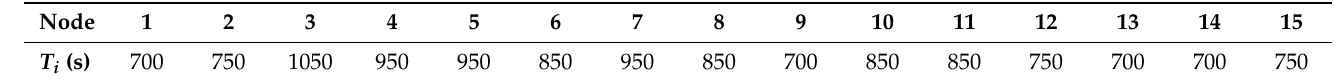
Figure 11. The monitoring period in an incomplete environment obtained by OMACO algorithm. 5. Conclusions This research has studied the problem of multi-UAV persistent monitoring path planning from the perspective of monitoring privacy protection, reducing monitoring overdue events, and improving the privacy protection of the monitoring trajectory. A multi-UAV path planning mathematical model was established based on the monitoring overdue time and monitoring period entropy. Based on the overdue time, the heuristic function, transition probability and pheromone update, the strategy of the traditional ACO is improved. The simulation results show that the proposed OMACO algorithm can solve the optimal UAV flight path efficiently in both complete and incomplete monitoring environments and has better performance than ACO. This study is promising for the pre- vention of intelligent intrusions while meeting the requirements of regular monitoring. However, as the complexity of the monitoring environment increases, there may be adversarial targets destroying monitoring tasks, and the privacy protection requirements may be more stringent. Subsequent consideration will be given to localize adversarial ob- jects cooperatively while executing persistent monitoring assignments. Author Contributions: Conceptualization, Y.C.; methodology, Y.S.; software, Y.C. and Y.S.; formal analysis, Y.C. and Y.S.; investigation, Y.C. and Y.S.; writing—original draft preparation, Y.S.; writ- ing—review and editing, Y.C., M.H. and X.Z.; supervision, Y.C. All authors have read and agreed to the published version of the manuscript. Funding: This research was funded by the Joint fund of Science & Technology Department of Liao- ning Province and the State Key Laboratory of Robotics with Grant No. 2021-KF-22-14. Institutional Review Board Statement: Not applicable.